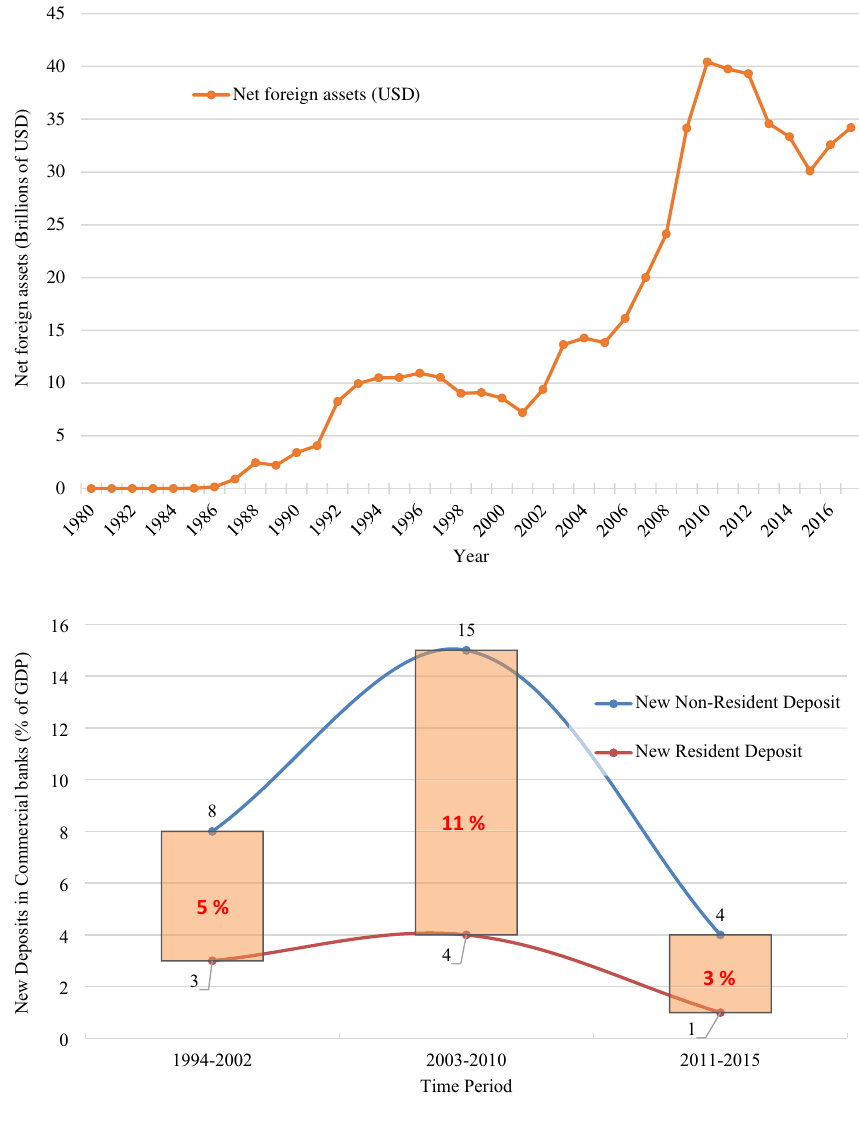
Fig. 4 New Deposits in Com- mercial banks ( Source : World Bank Group